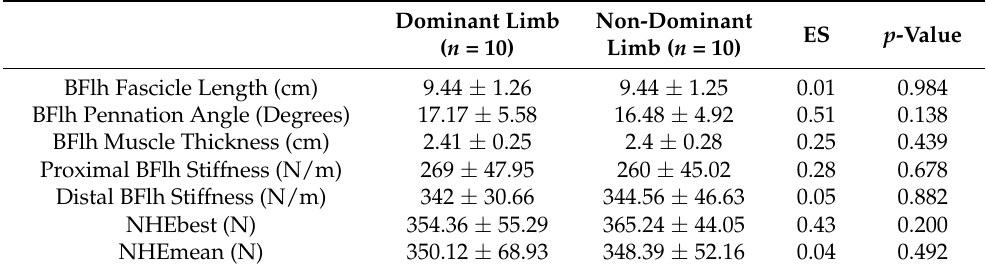
Table 4. Comparative data between dominant and non-dominant limbs in uninjured players. Data are presented as mean ±